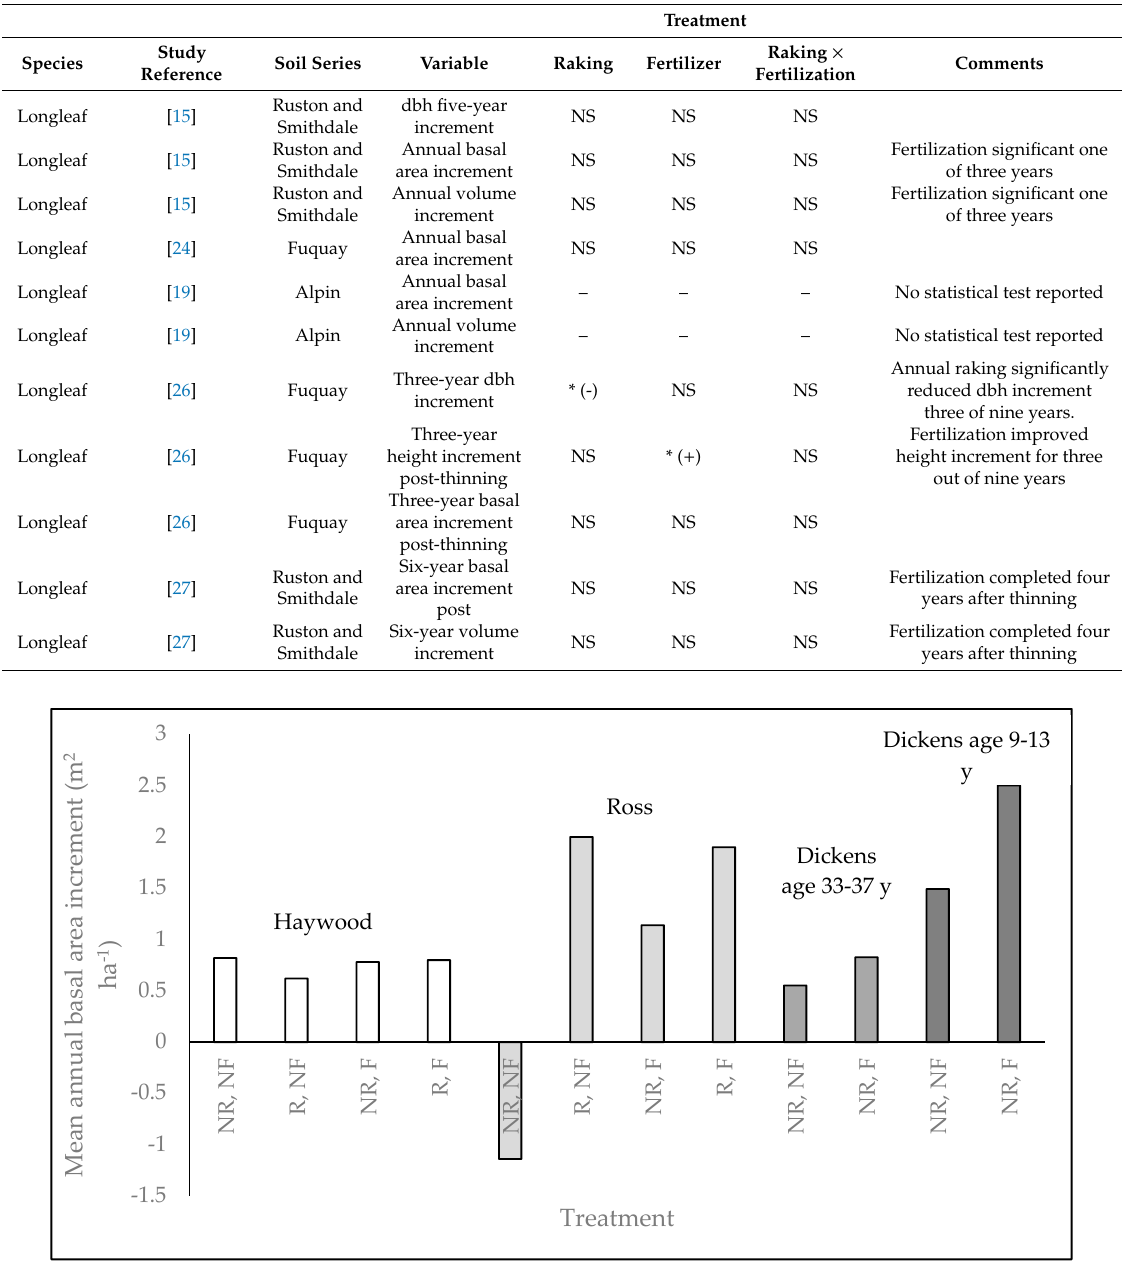
Figure 5. Longleaf pine mean annual basal area increment by treatment [15,19,24]. Treatments: no rake, no fertilization (NR, NF); rake, no fertilization (R, NF); no rake, fertilization (NR, F); rake, fertilize (R, F) (refer to Tables 2 and 5 for study details, information on fertilizer treatments, and statistical test results).